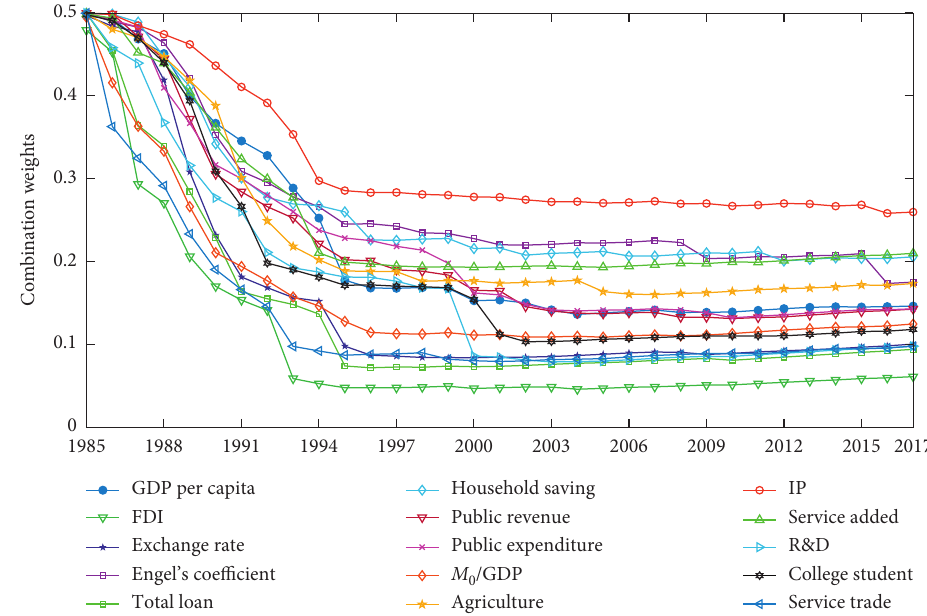
Figure 3: Inclusion probability (forecasting weights) for various nonenergy predictors.